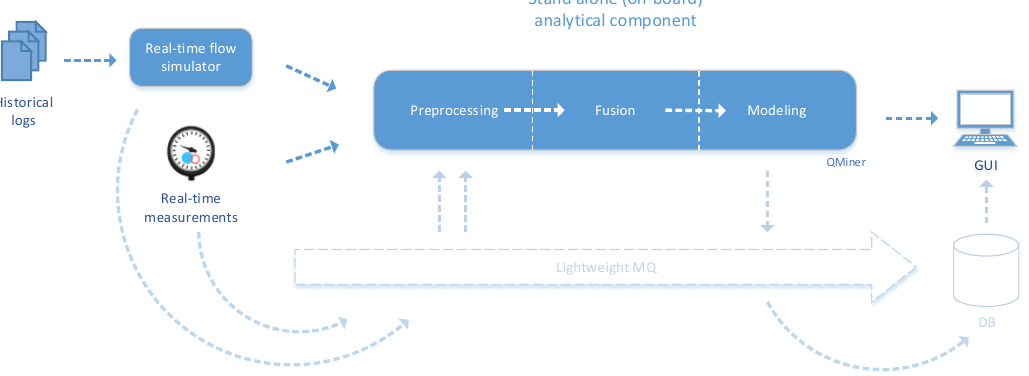
Figure 5. Data fusion framework integration in the edge/fog scenario. Message queue system can be completely omitted in this scenario and all communication is achieved via HTTP API or WebSockets (on the GUI part). Components are tightly coupled to ensure faster data